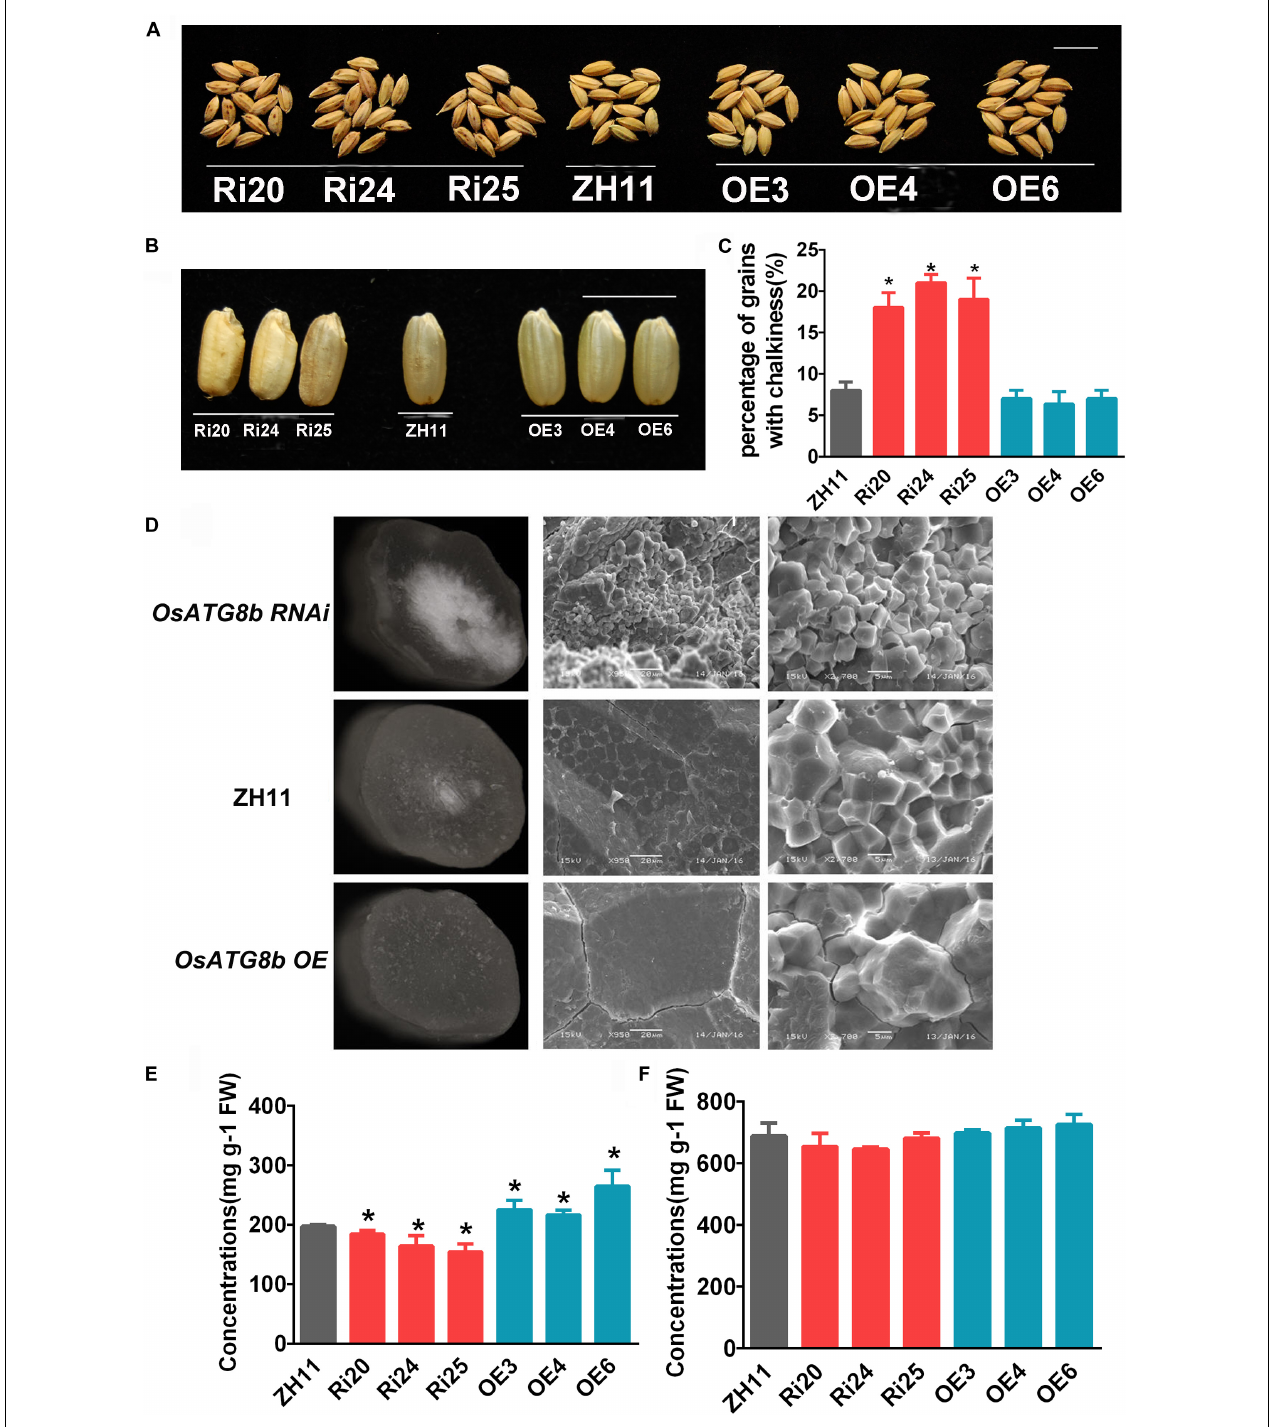
FIGURE 6 | OsATG8b -mediated autophagy affects grain quality in rice. OsATG8b -RNAi (Ri) and OsATG8b -OE (OE) lines and ZH11 were grown in a paddy field under normal growth conditions. (A) Seed grains. OsATG8b -RNAi lines produced grains with brown spotted hulls. Bar = 1 cm. (B) Hulled OsATG8b -RNAi rice lines showed a chalky endosperm phenotype. Bar = 1 cm. (C) Percentage of hulled rice with chalkiness. (D) Scanning electron micrographs of cracked mature caryopses of rice grains under different magnifications. Endosperms of OsATG8b -RNAi lines had small, loosely packed starch granules, which differed markedly from the large, tightly packed starch granules of ZH11 and OsATG8b- OE lines. (E) Soluble protein concentration in grains. (F) Starch concentration in grains. Three biological replicates, each containing 40 seeds from five plants, were used for data analysis. Results are the mean ± SD from five plants. * p < 0.05 ( t -test): significantly different from ZH11 (C,E,F)